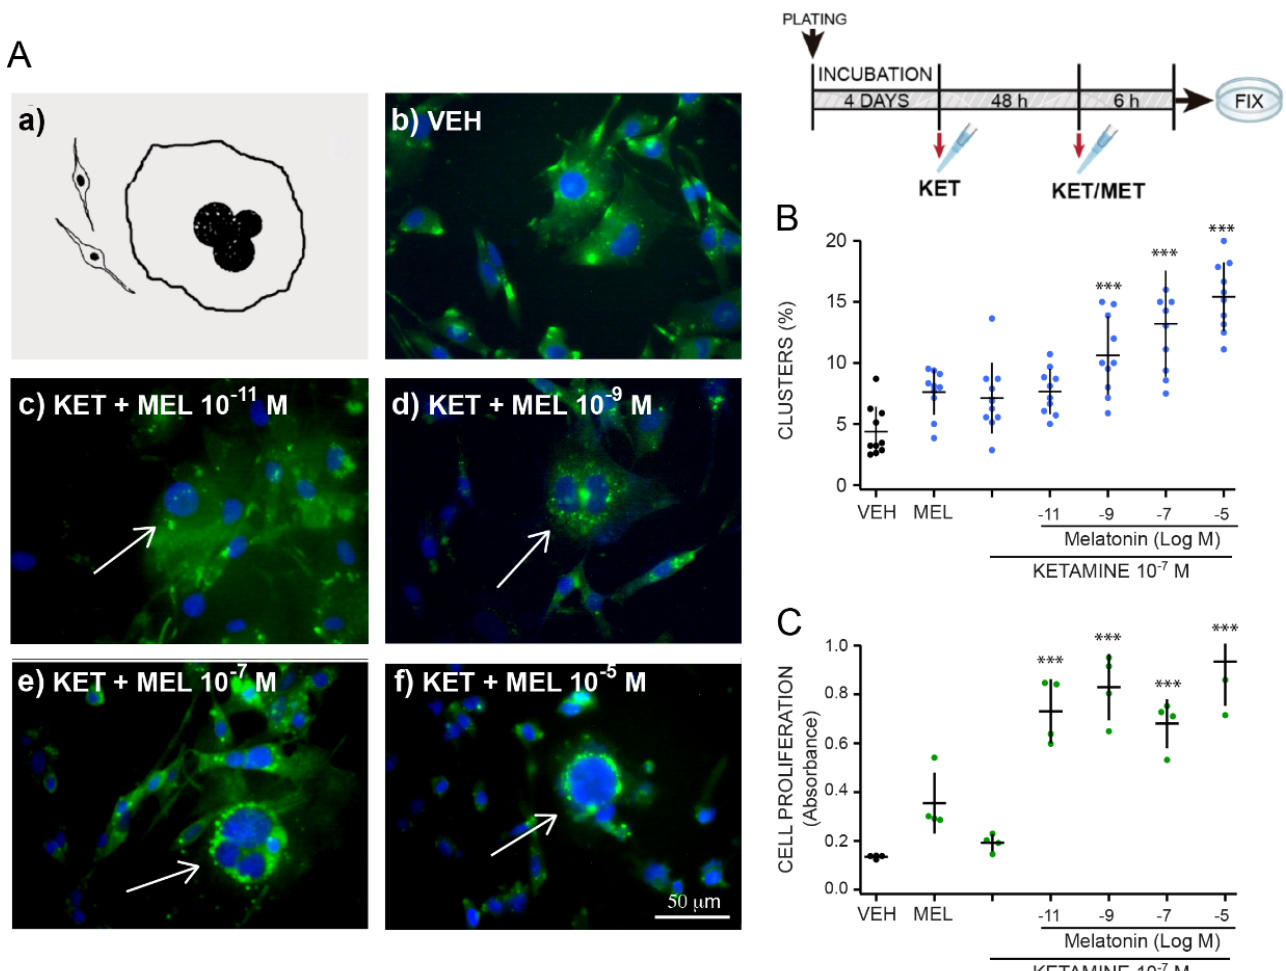
Figure 3. Concentration response effect of melatonin in combination with ketamine on formation of clusters in ONPs cultures pre-incubated for 48 h with ketamine. Olfactory neuronal precursors were cultured during 48 h with either the vehicle (VEH) or ketamine (KET 10 − 7 M) and then with KET (10 − 7 M) together with various MEL (10 − 11 to 10 − 5 M) concentrations. Cells were fixed and stained with an anti-nestin antibody followed by a secondary antibody coupled to FITC (green), and DAPI (blue). The inset to the right, above, shows the treatment scheme. Panel A shows a diagram of a typical cluster ( a ). Representative merged images of neuronal precursors incubated with the VEH ( b ) or KET 10 − 7 M for 48 h followed by incubation with the combination of KET 10 − 7 M with either 10 − 11 M ( c ), 10 − 9 M ( d ), 10 − 7 M ( e ) or 10 − 5 M ( f ) MEL. Bar = 50 µ m. Clusters are pointed at using an arrow. Panel B shows the graph of the effect of melatonin on cluster formation in cells preincubated with 10 − 7 M KET for h. Clusters were counted in 10 fields in cultures treated as described and normalized by total number of cells in the field counted by DAPI staining (n = 10). Panel C shows a graph of the concentration–response curve of MEL effects on cell proliferation of ONPs cultured with KET 10 − 7 M determined by formazan formation. Each point represents the mean of absorbance values measured in 4 wells. The mean ± standard deviation of the mean (SEM) is from 1 or 2 experiments performed by quadruplicate. Each experiment was repeated three times. Data was analyzed by one-way ANOVA with Dunnett ´ s post-test. *** p = 0.001 when compared with vehicle (VEH)